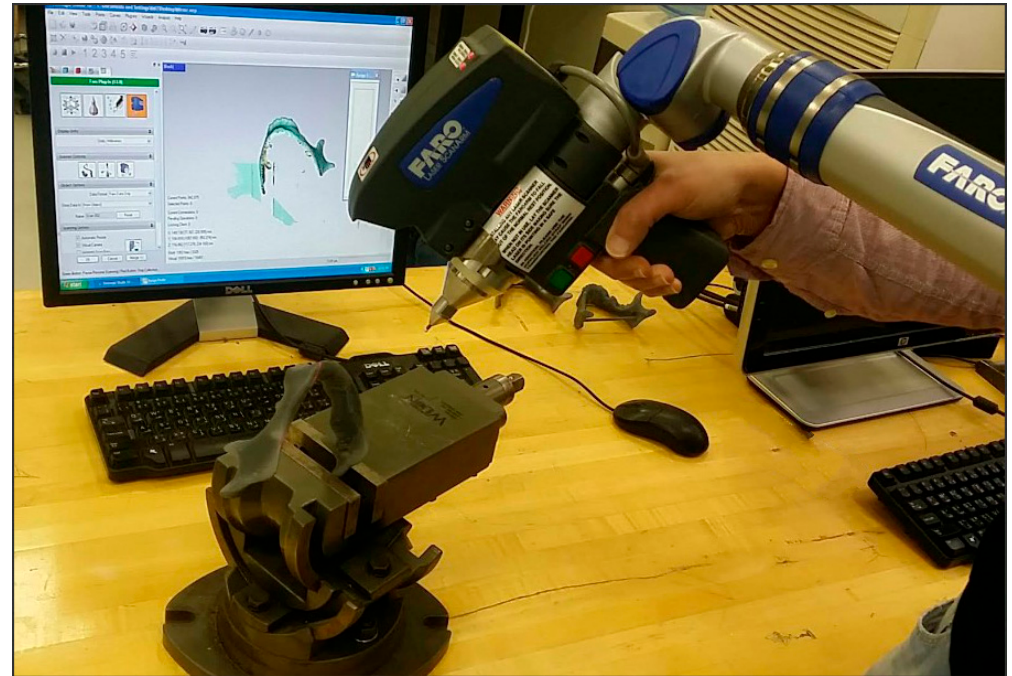
Figure 11. Data acquisition from FDM-reconstructed models using a FARO arm laser scanner.